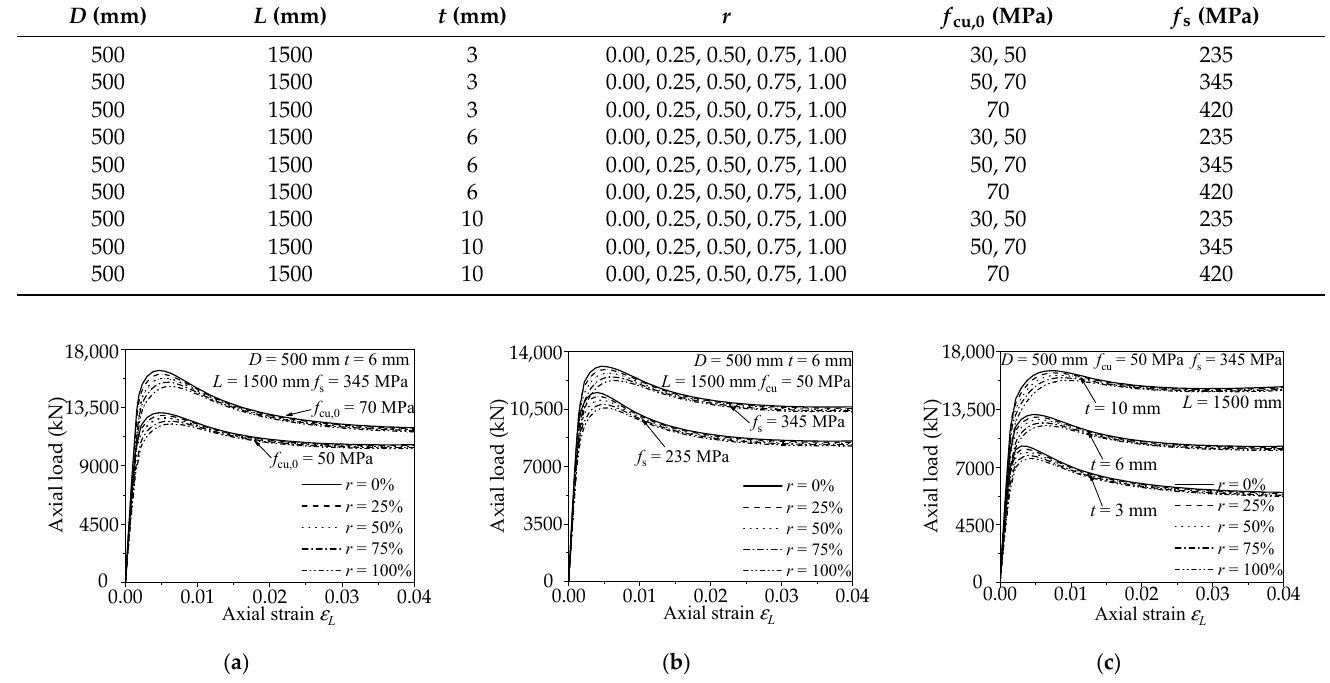
Table 3. Material and geometric properties of specimens for FE parametric study.